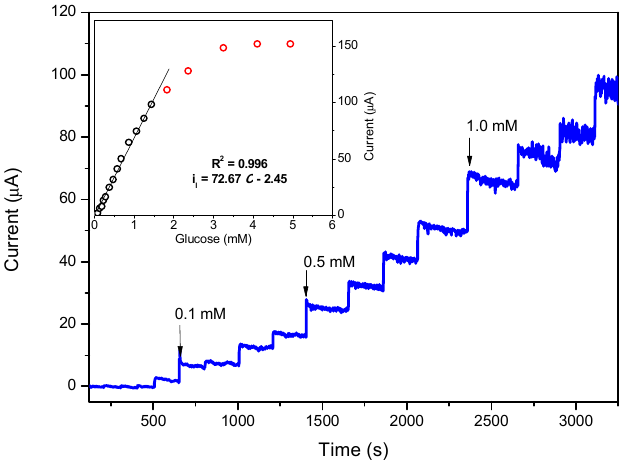
Figure 6. Chronoamperometry of 20 µL N-CS/SPCE in 0.1 M KOH after successive additions of glucose at an optimal applied potential of 0.6 V; inset shows the corresponding calibration curve.